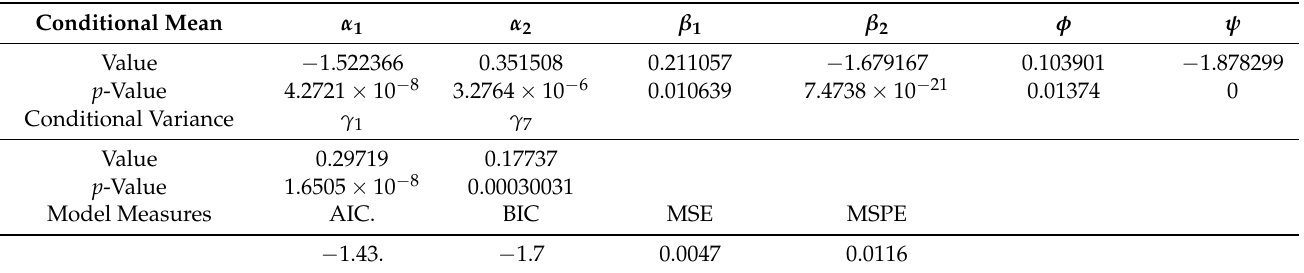
Table A3. Parameter values and corresponding p -values for the SARIMA-GARCH model (7)–(8).